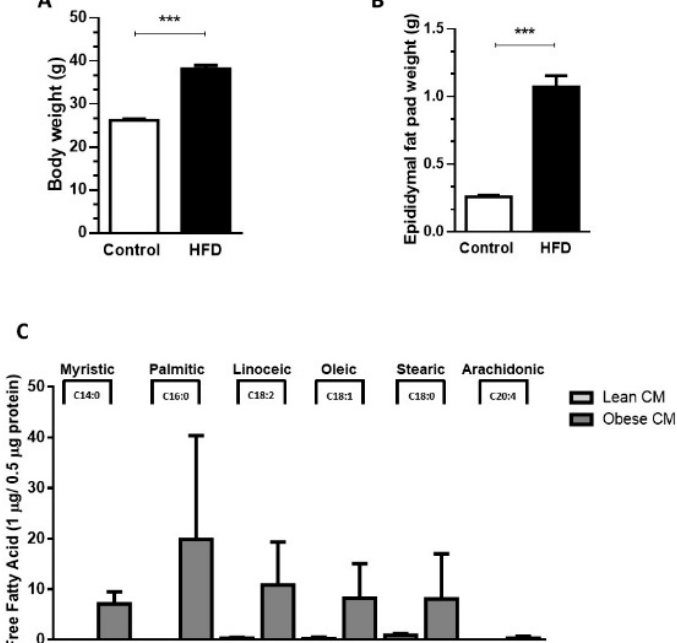
Figure 1. Male mice were randomly housed in cages ( n = 4 animal per cage) and, after weaning were fed either with regular control chow (CTL; 13% of energy derived from fat) or high-fat-diet (HFD; 45% of energy derived from fat) until 90 days of age. ( A ) Body weight and epididymal fat pad ( B ) were measured after 90 days. Results are representative of 28 at least 30 mice. Data are expressed as means ± SEM. *** p < 0.005 vs. control. ( C ). Epididymal adipose tissue depots were collected and maintained in culture in Dulbecco’s modified Eagle’s medium (DMEM) 1% FBS for 24